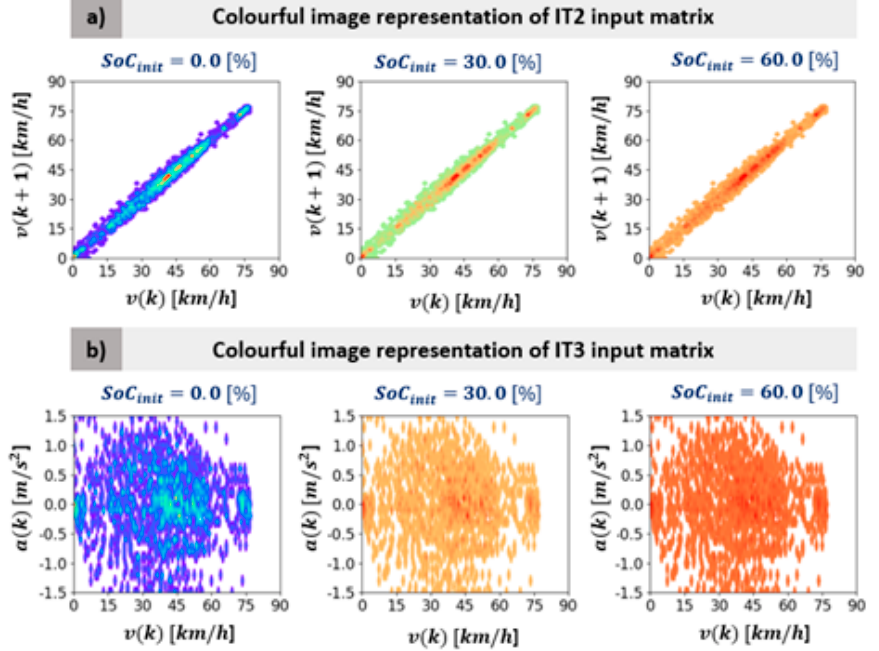
Figure 4. Contour plots of IT2 and IT3 input matrices for initial SoC values equal to 0%, 30% and 60%.